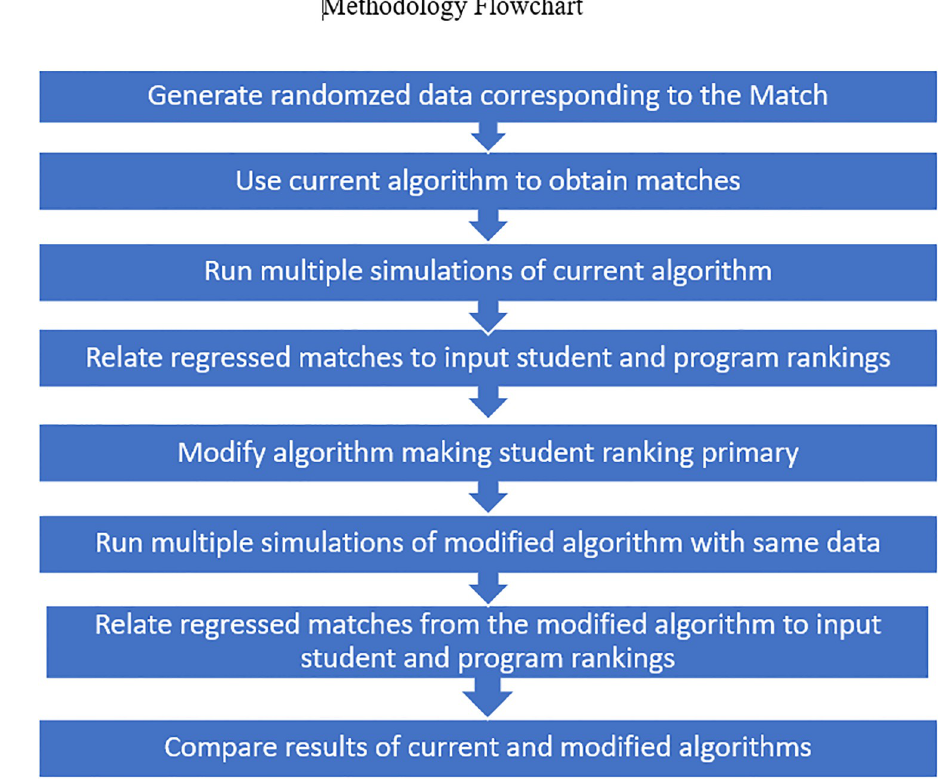
Fig 1. The flowchart below summarizes the